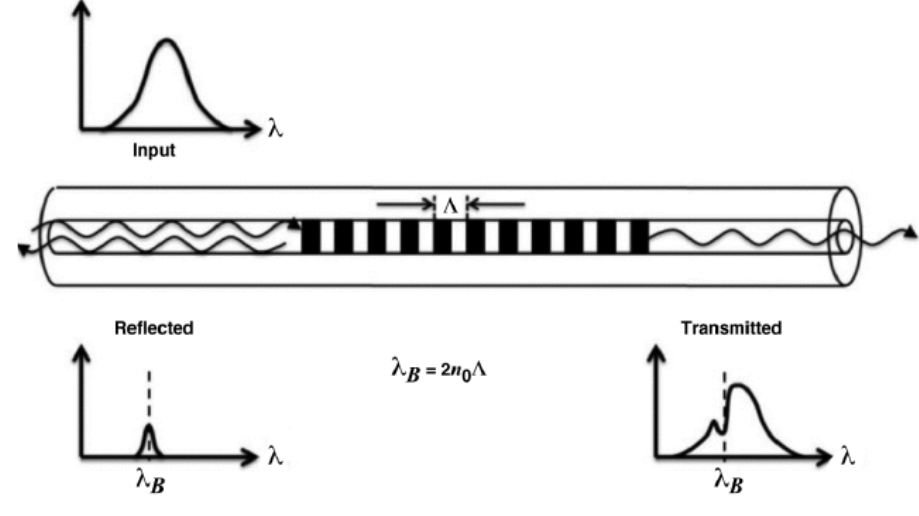
Figure 7. Bragg grating design and mechanism [48].